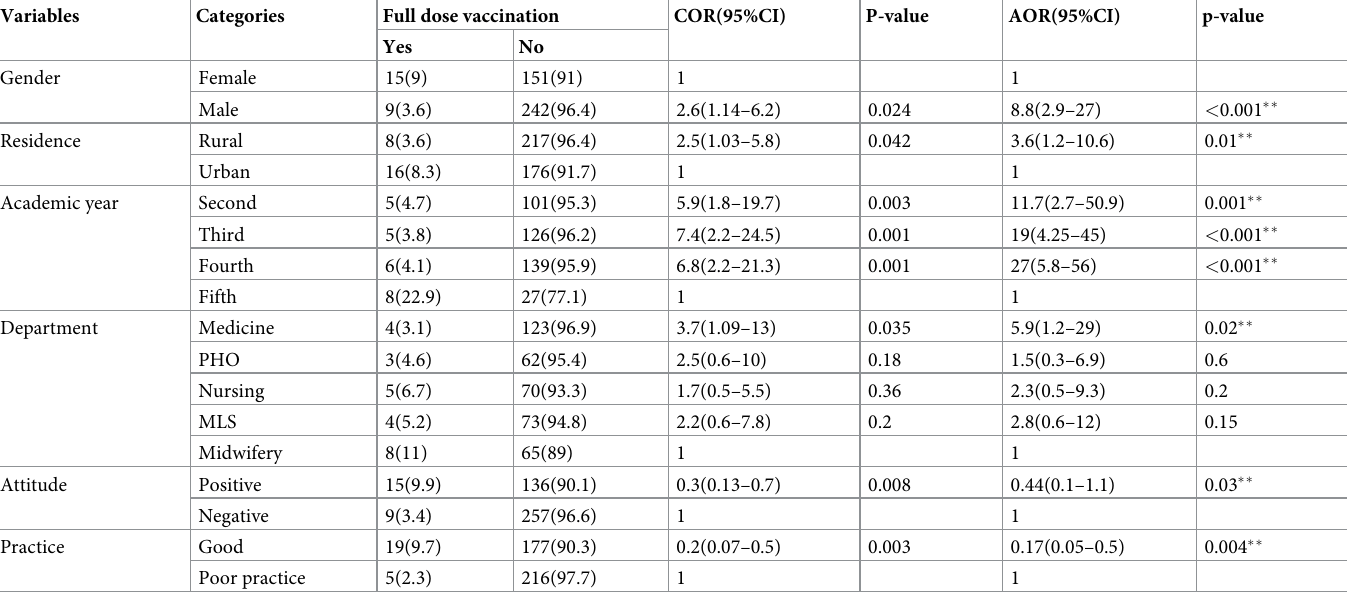
Table 5. Factors associated with full-dose vaccination status among study participants,